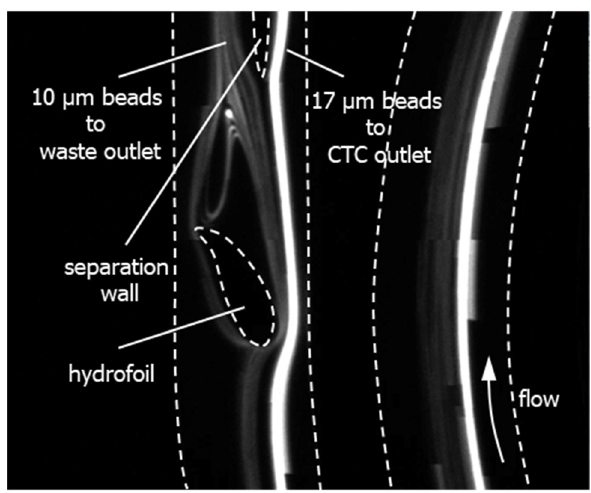
Figure 5. Visualization of the separation of beads at the hydrofoil region according to their sizes. Dash lines represent the boundaries of the flow.